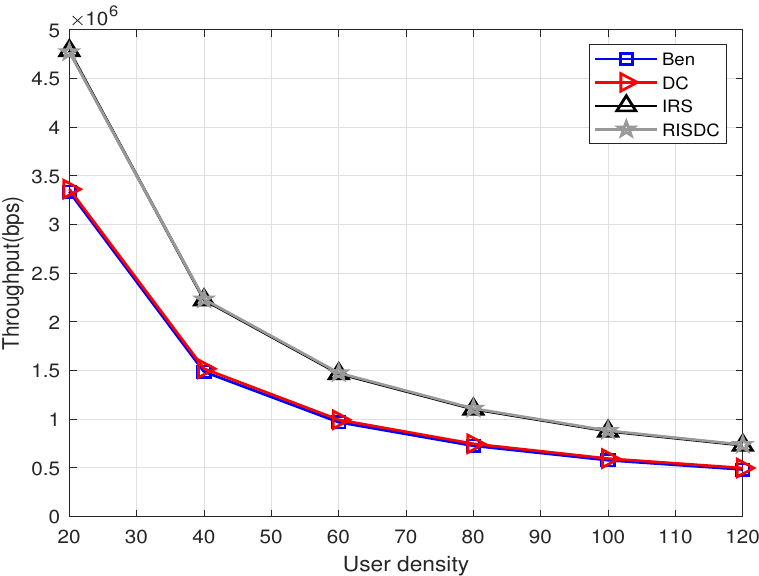
Figure 6. Variation of throughput with respect to number of users when ρ bs = 2, ρ ris = 6, α = 1, and µ b =